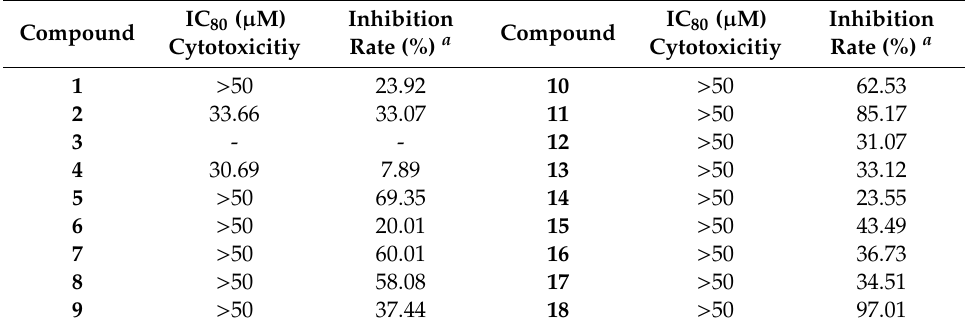
Table 2. The cytotoxicities and inhibitory e ff ects of the isolates from C. takesimana on